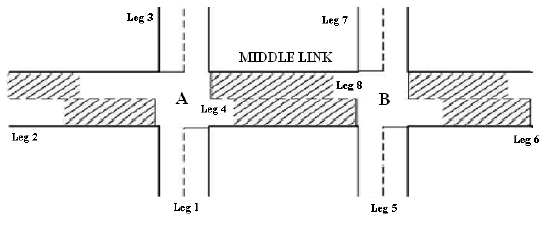
Figure 1. An arterial with two